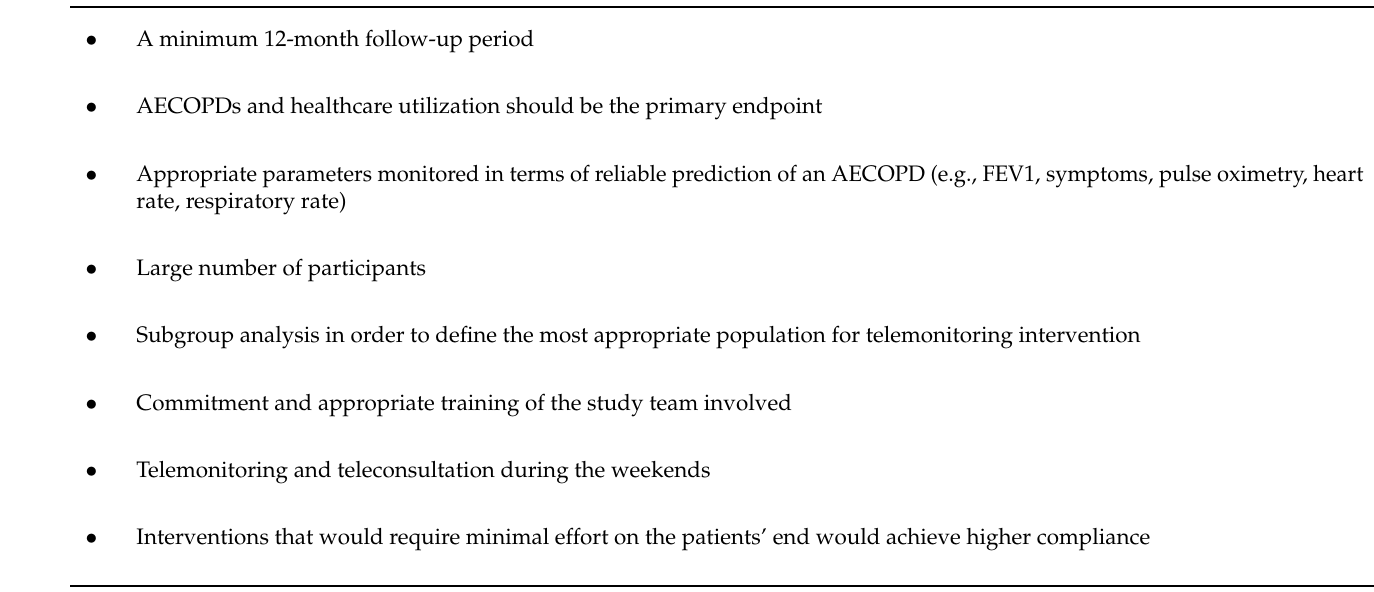
Table 3. Proposed characteristics of future